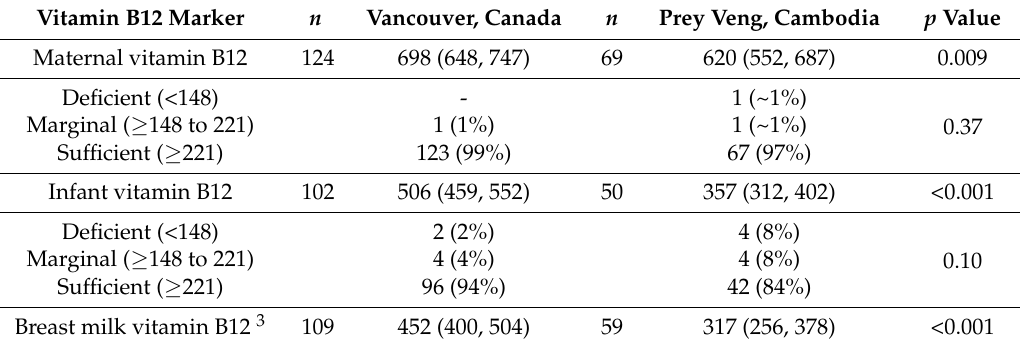
Table 1. Vitamin B12 status among mothers and their infants in Vancouver, Canada, and Prey Veng province, Cambodia 1,2 .